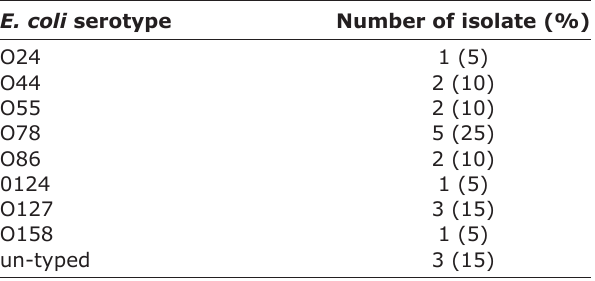
Table-2: Serotypes and percentages of 20 CR-positive E. coli